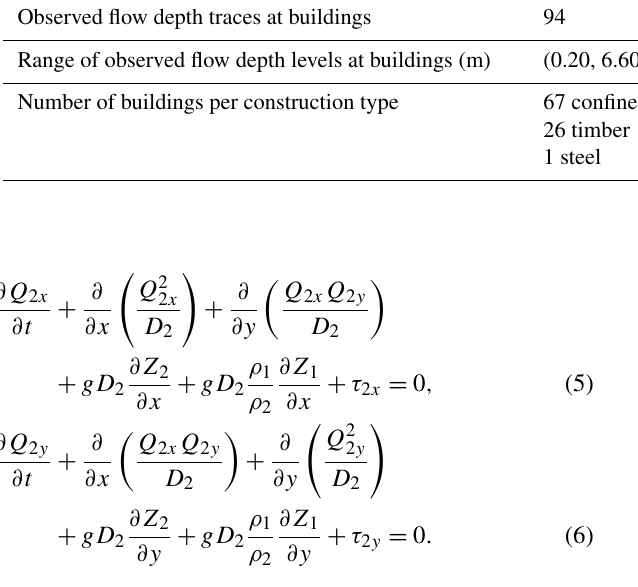
Table 2. Observed flow depth traces at buildings, range of flow depth levels, and building characteristics in DB_Sunda2018, DB_Palu2018, and DB_Thailand2004. DB_Sunda2018 DB_Palu2018 DB_Thailand2004 Observed flow depth traces at buildings 94 124 117 Range of observed flow depth levels at buildings